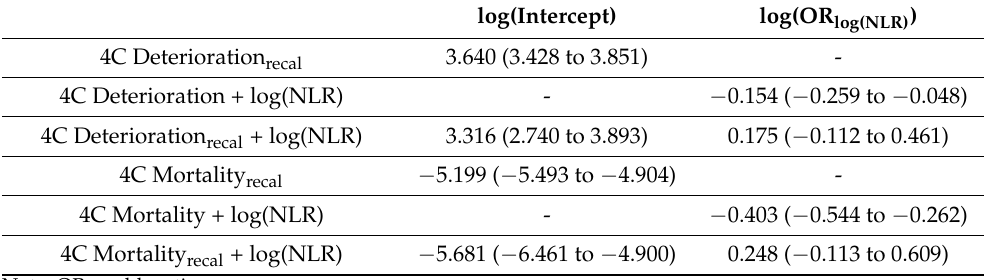
Table 3. Pooled neutrophil-to-lymphocyte ratio (NLR) and recalibrated intercept